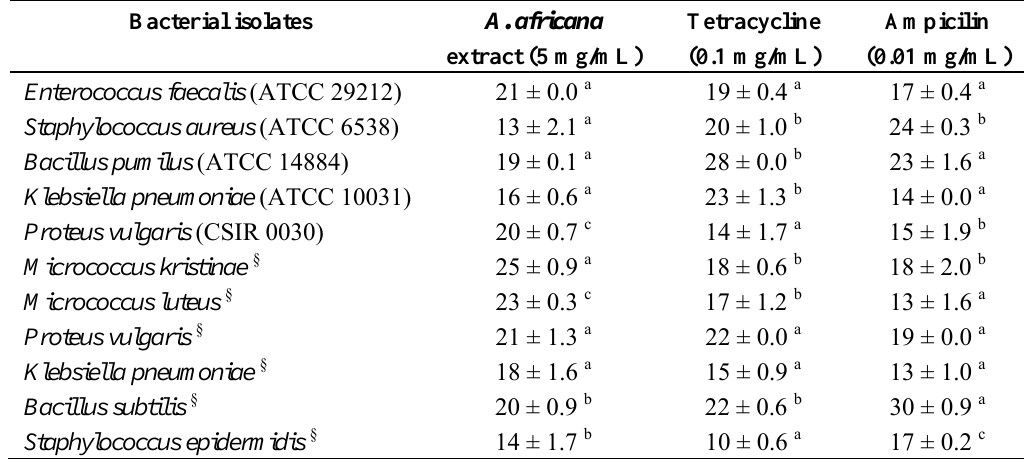
Table 1. Sensitivity patterns of zones of inhibition exhibited by A. africana crude methanol stem bark extract against the bacterial isolates Bacterial isolates.